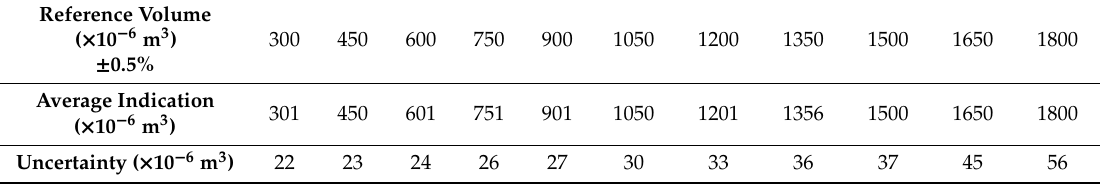
Table 2. Measurements after calibration.